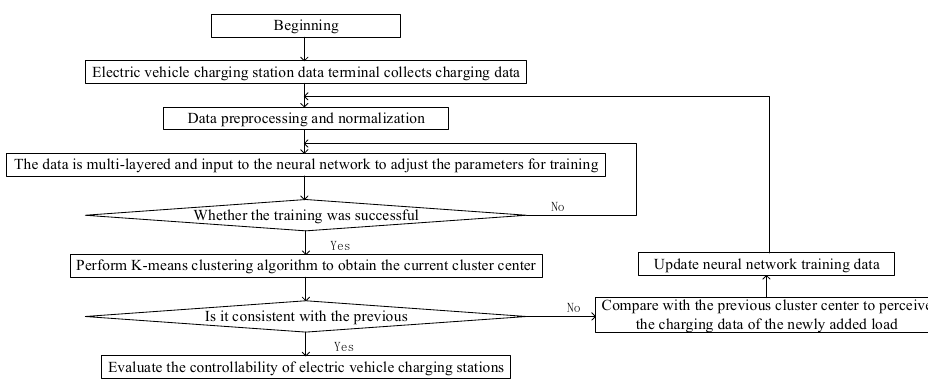
Figure 3. Non ‐ intrusive load monitoring process of electric vehicle charging station based on deep learning.